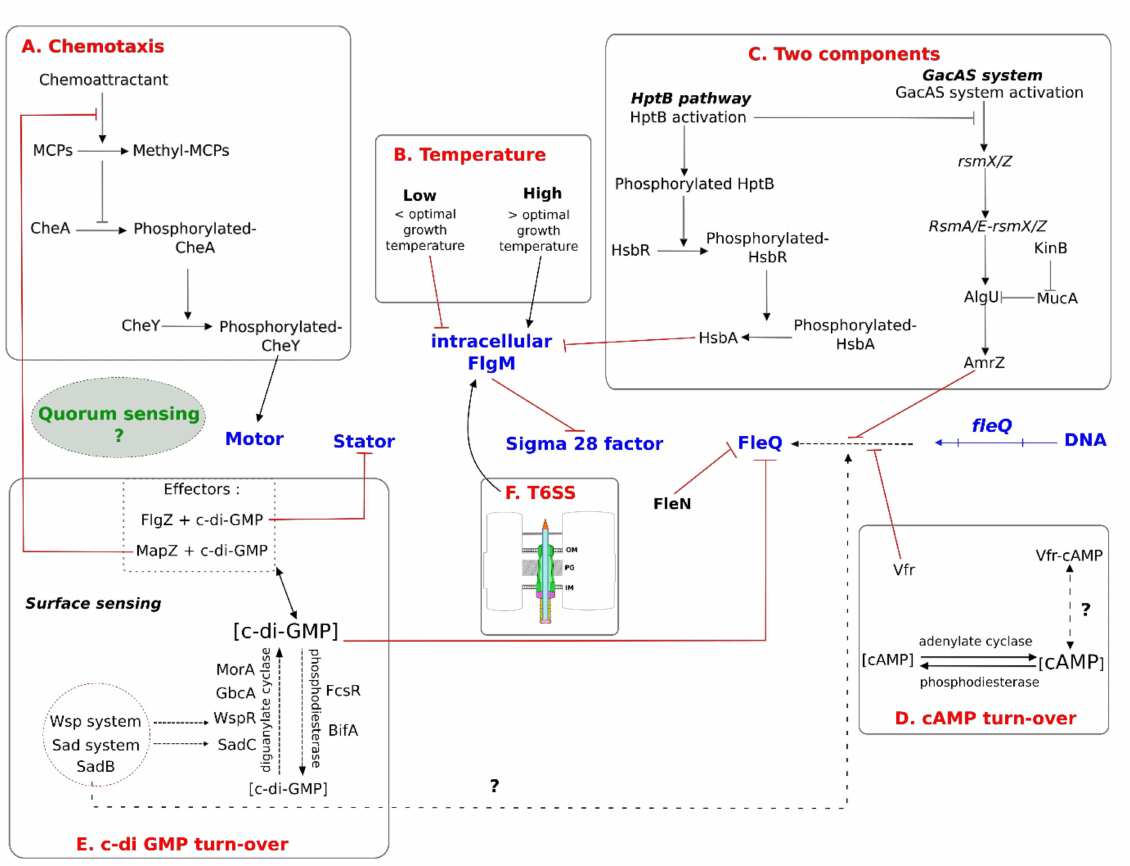
Figure 4. Regulation of flagella in Pseudomonas . The assembly and function of flagella in Pseudomonas are regulated by various mechanisms, such as ( A ) chemotaxis, ( B ) temperature, ( C ) two-component systems, ( D ) cAMP concentration, ( E ) c-di-GMP concentration, and ( F ) T6SS. Quorum sensing (QS) (represented in a green bubble) also appears to be involved but no data on the regulation of Pseudomonas flagella by QS are available. The key elements and regulators of flagella are written in blue. Black arrows indicate positive regulation, dotted arrows indicate potential positive regulation, double arrows indicate an interaction, dotted double arrows correspond to a potential interaction, blunt red lines represent negative regulation, and question marks indicate an unknown mechanism or